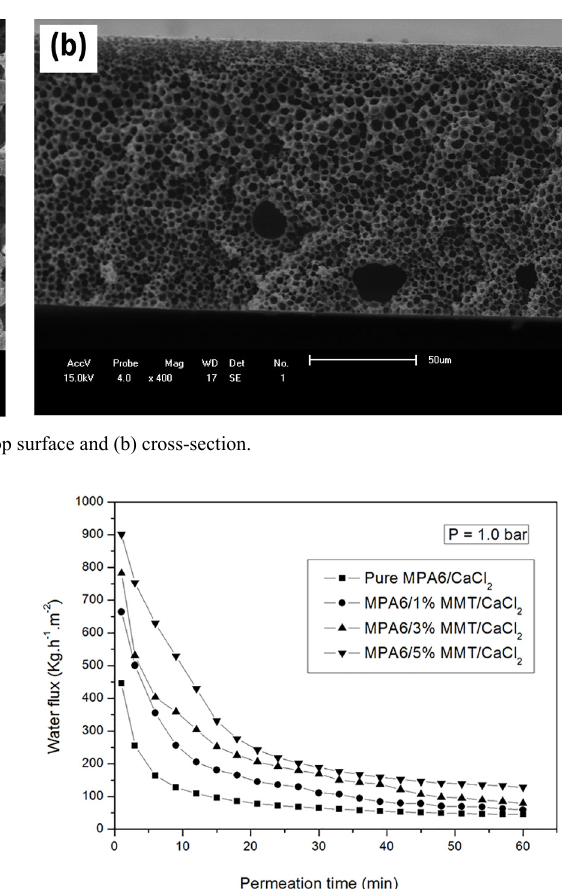
Figure 8. Distilled water flux curves for pure PA6 membranes and , by the their hybrids with 1, 3, 5% of MMT, adding the additive CaCl 2